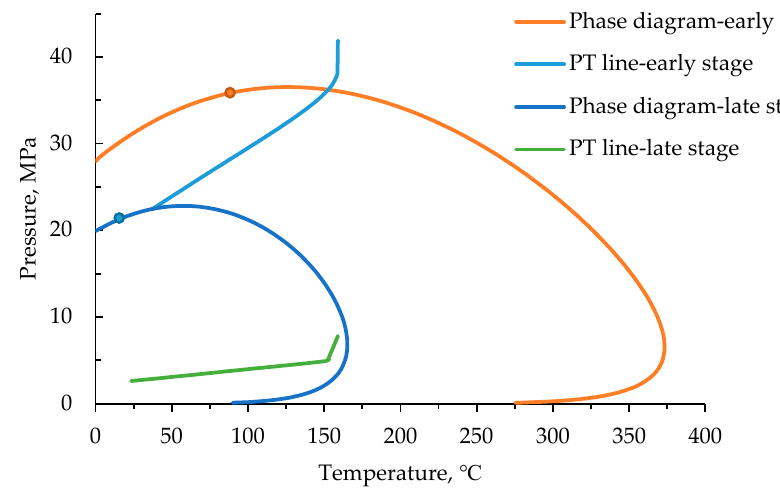
Figure 5. The well fluid phase diagram, fluid PT lines in different periods.